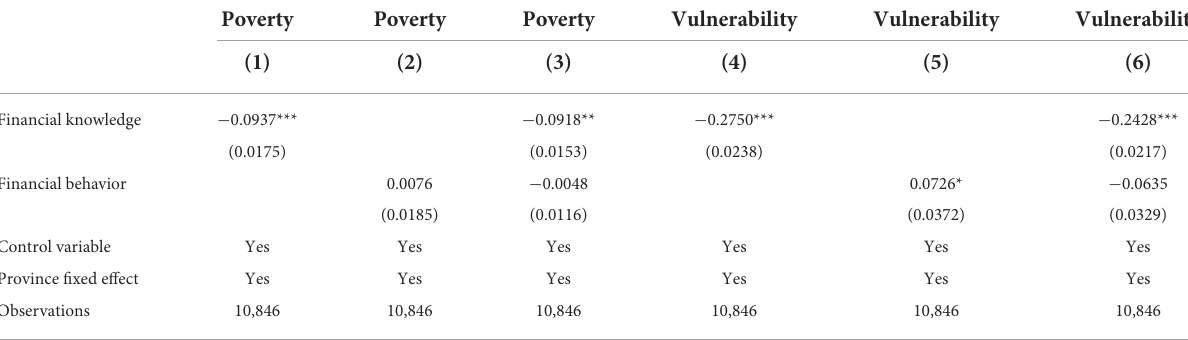
TABLE 5 Distinguishing different dimensions: the impact of household financial literacy on relative